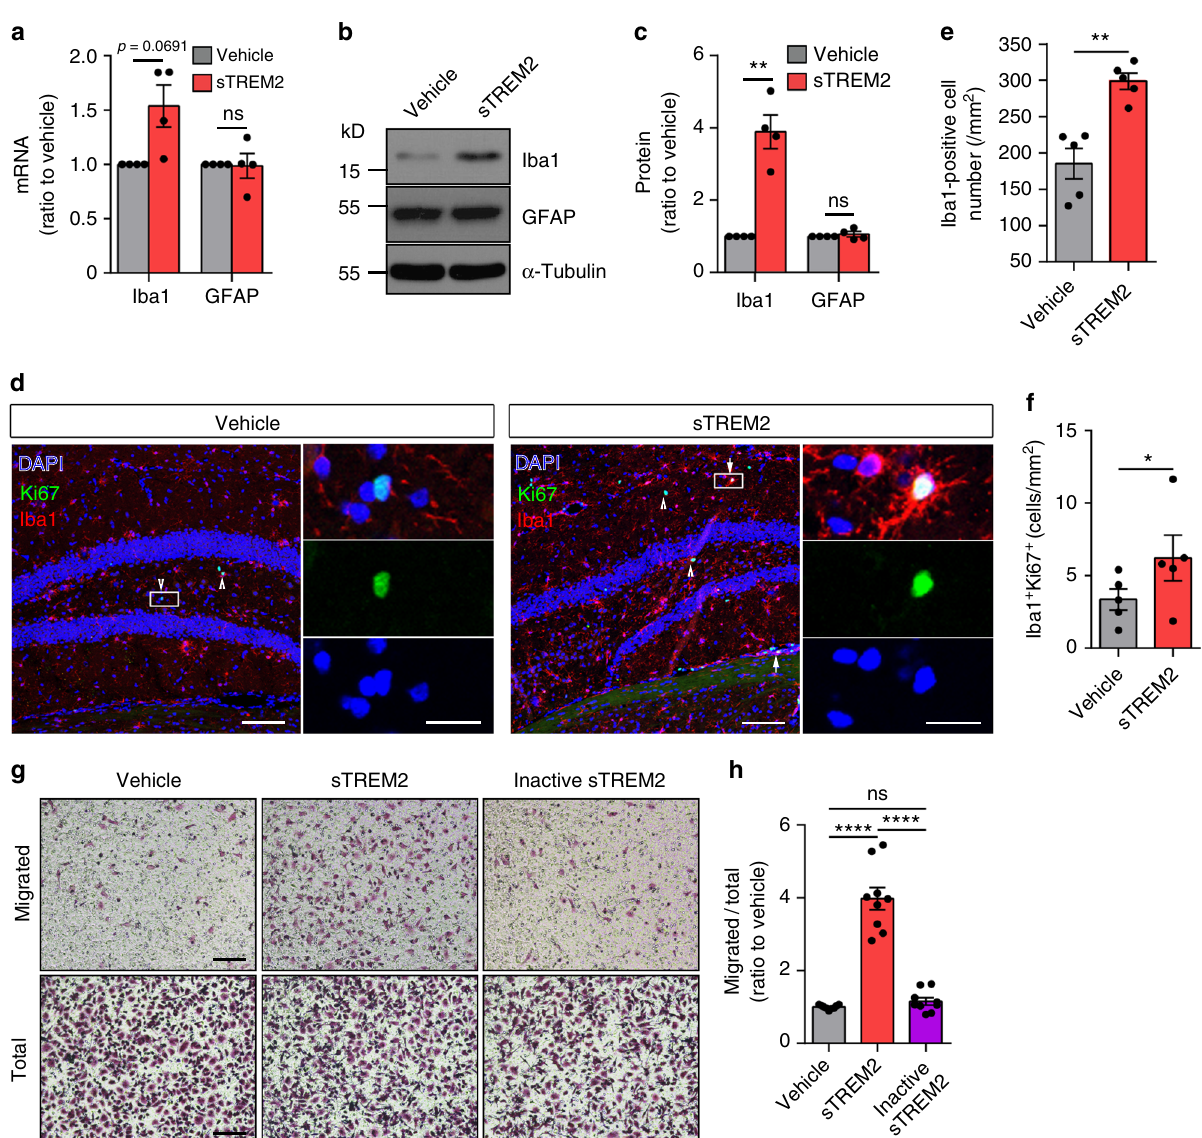
Fig. 2 sTREM2 promotes microgliosis in 5×FAD mice and microglial migration. a The hippocampus was dissected from vehicle- or sTREM2-injected 5×FAD mice. After RNA extraction, the relative mRNA levels of Iba1 and GFAP in the hippocampus shown as a bar graph were determined by quantitative real- time PCR. β -actin was used as an internal control ( n = 4 mice per group, paired Student ’ s t test). b Iba1 and GFAP proteins were analyzed by Western blotting 7 days after sTREM2 injection to the hippocampus of 5×FAD mice. c Quantitation of the protein levels of Iba1 and GFAP in b ( n = 4 mice per group, paired Student ’ s t test). d Coronal sections from injected 5×FAD mice were stained with DAPI (blue) for nuclei, Ki67 (green) for proliferating cells, and Iba1 (red) for microglia. Representative z-stack images of the hippocampus regions are shown. Original magni fi cation ×20; scale bar, 100 μ m. Images on the right represent enlarged Ki67-positive cells with a scale bar equal to 20 μ m. e Quantitation of the number of Iba1-positive cells in d ( n = 5 mice, 22 fi elds of each group for analysis, paired Student ’ s t test). f Quantitation of the number of proliferating microglial cells, as indicated by the co-staining of Ki67 and Iba1 (Iba1 + Ki67 + ) ( n = 5 mice, 22 fi elds of each group for analysis, paired Student ’ s t test). g Primary microglial cells (10 5 ) from WT mice were plated onto transwell chamber inserts. Following 24-h incubation with vehicle (PBS), native sTREM2 protein (100 nM), or heat-inactivated sTREM2 protein (100 nM), cells migrated through the membrane were stained with hematoxylin and eosin and imaged under a Nikon inverted microscope. Scale bar, 100 µ m. h Quantitation of the number of migrated cells ( n = 9 from three independent experiments, one-way ANOVA). All data are presented as mean ± SEM. * p < 0.05; ** p < 0.01; **** p < 0.0001; ns, not signi fi